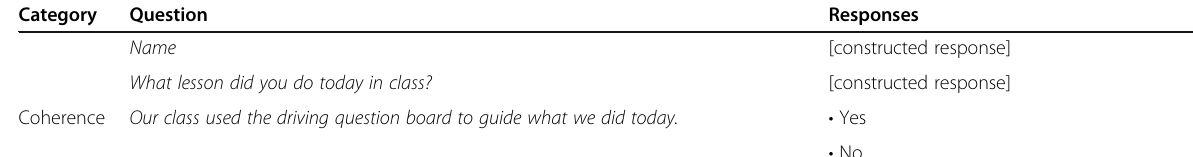
Table 3 The student exit